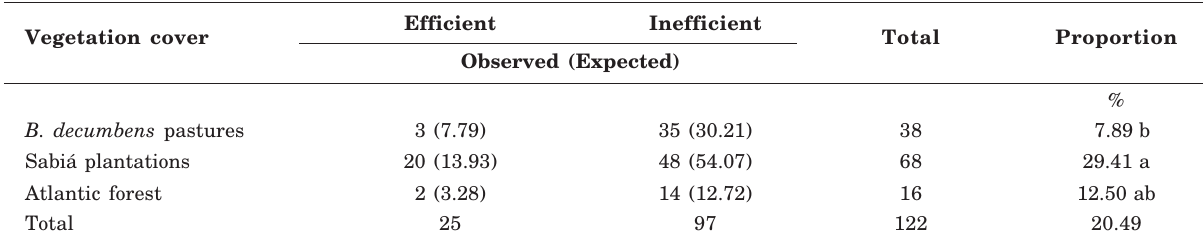
Different letters indicate significant differences (p<0.05) in the proportion of efficient